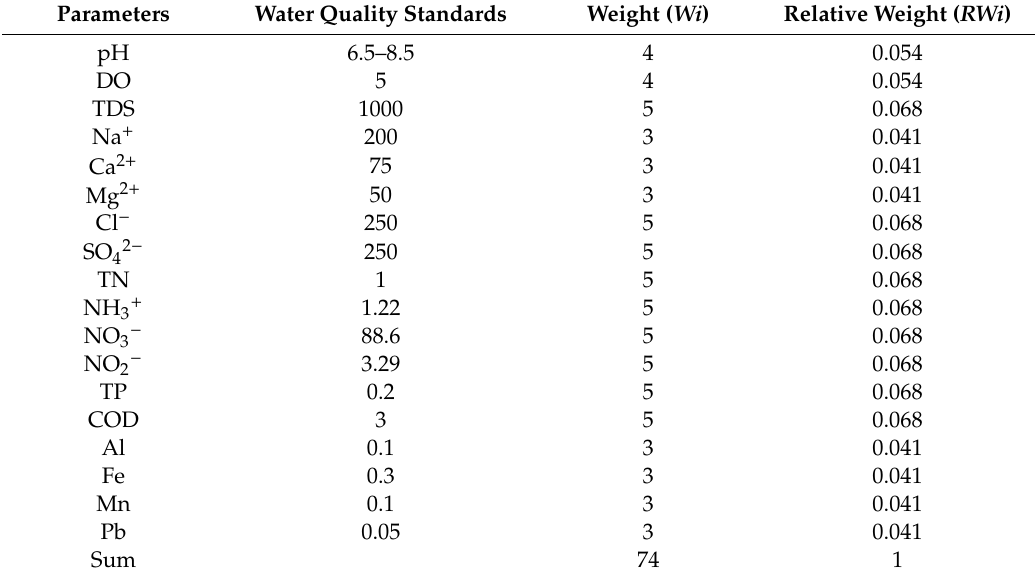
Table 1. Relative weight of water quality parameters and water quality standard (all units of the parameters are in mg / L except